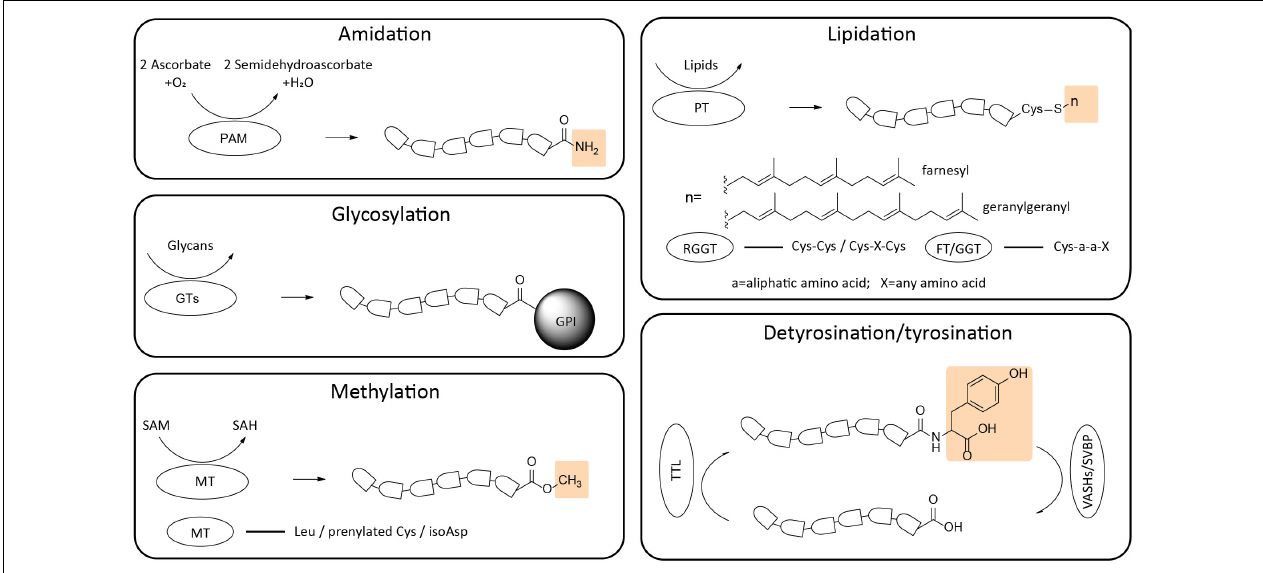
FIGURE 2 | Schematic representation of structural formulas and enzymatic preferences of C-terminal modifications. The C-terminal modifications include amidation, glycosylation, methylation, lipidation and detyrosination/tyrosination (yellow boxes indicate the function groups added to the termini). Corresponding recognition sites of different enzymes are listed. PAM, peptidylglycine α -amidating monooxygenase; GTs, glycosyltransferases; MT, methyltransferase; PT, prenyltransferase; RGGT, Rab geranylgeranyl transferase; FT, Farnesyl transferase; GGT, geranylgeranyl transferase; TTL, tubulin tyrosine ligase; VASHs/SVBP, vasohibins/small vasohibin binding protein